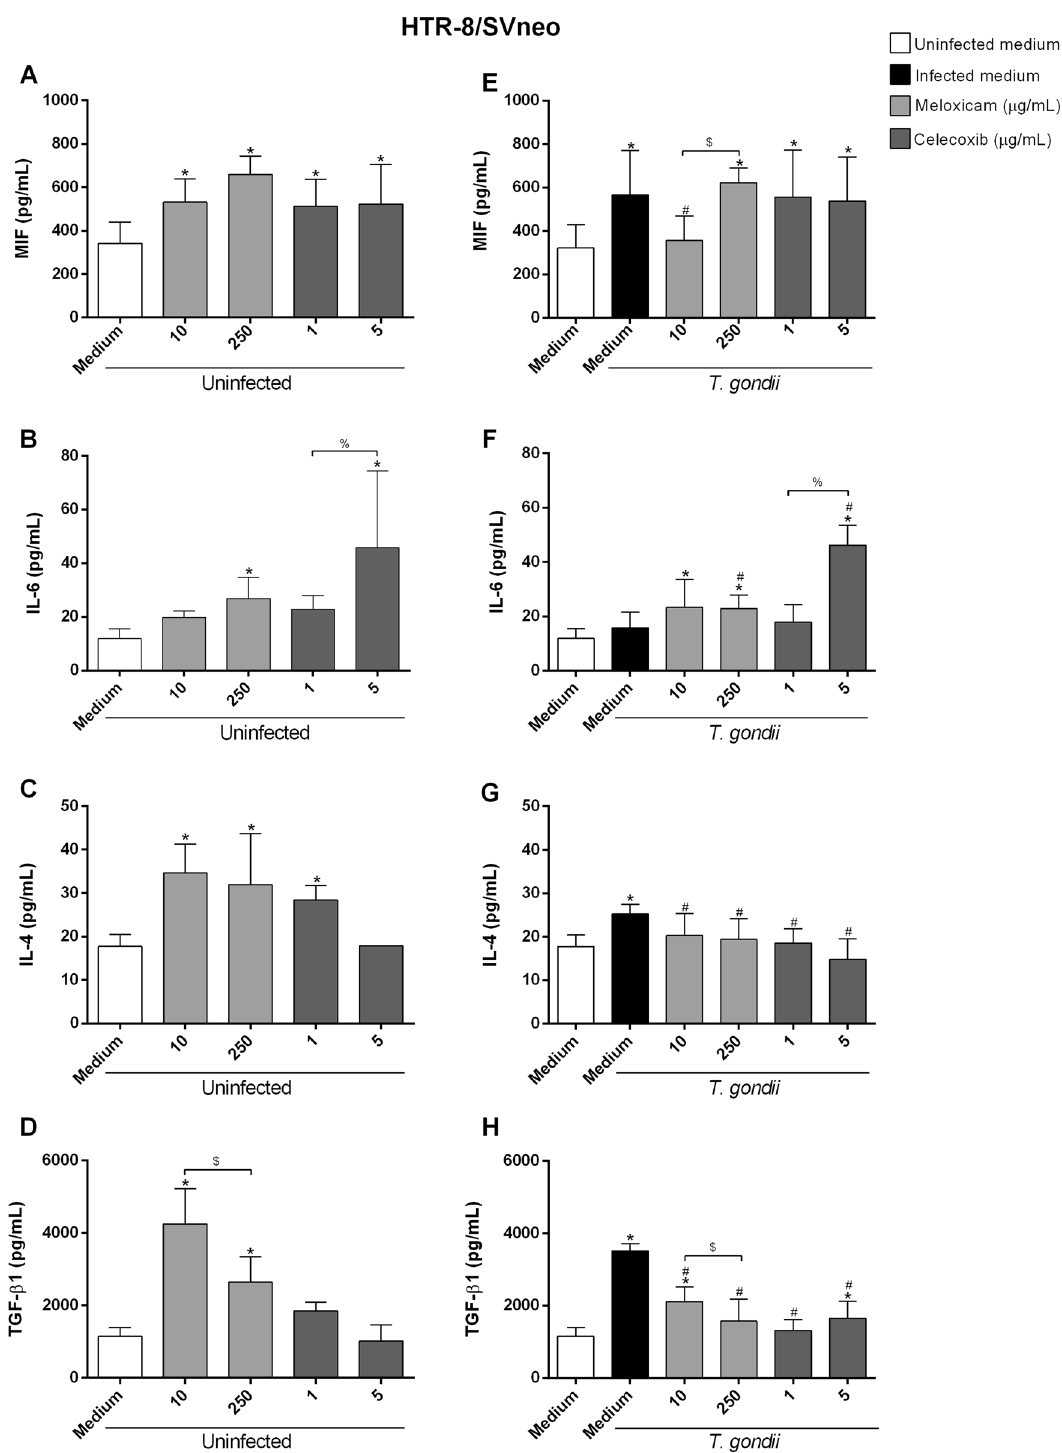
Figure 4. Cytokines production in HTR-8/SVneo cells infected and treated with COX-2 inhibitors. HTR-8/ SVneo cells were infected or not with T. gondii for 3 h and treated or not with meloxicam or celecoxib for an additional 24 h. Next, the supernatants were collected for measurement of MIF ( A , E ), IL-6 ( B , F ), IL-4 ( C , G ) and TGF-β1 ( D , H ) by ELISA. Data were shown as mean ± SEM from three independents experiments with eight replicates. Differences between groups were analyzed by One-Way ANOVA test with Sidak’s multiple comparison ( A , B , D , F , G , H ) or Kruskal–Wallis test and Dunn’s multiple comparison post-test ( C , E ) (GraphPad Prism Sofware version 6.01, https:// www. graph pad. com). Significant differences in relation to untreated and uninfected cells ( * uninfected medium), untreated and infected cells ( # infected medium), and between concentrations of meloxicam ( $ ) or celecoxib ( % ), regardless of infection. Differences were considered significant when P <